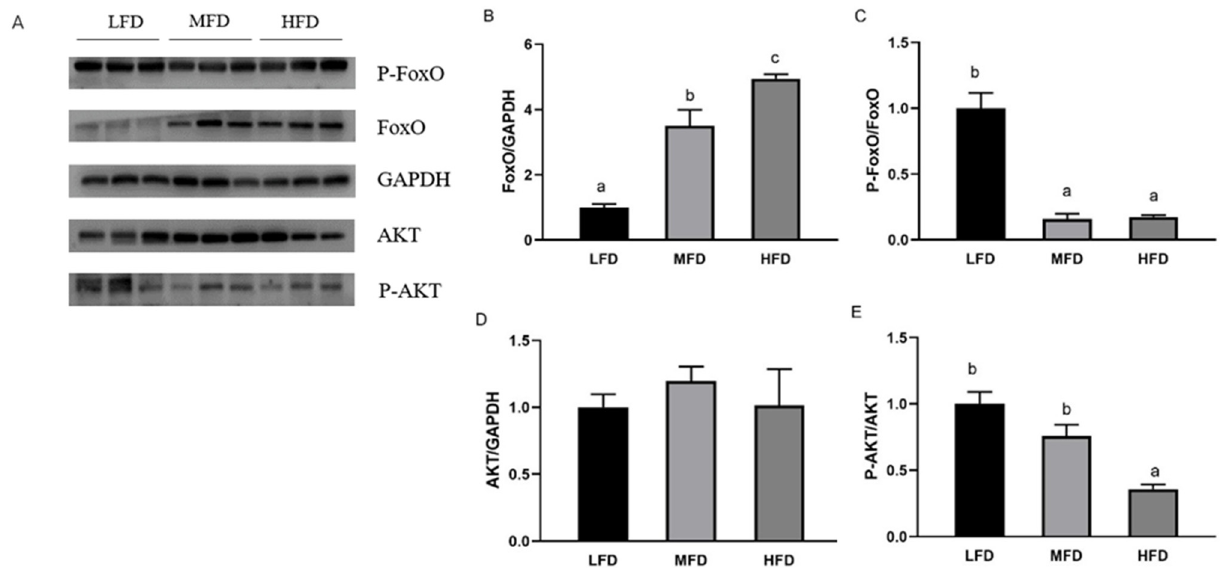
Figure 8. Protein levels in the hepatopancreas of abalone after feeding trial ( A ). The relative protein abundances of FoxO ( B ), P-FoxO ( C ), AKT ( D ), and P-AKT ( E ) in hepatopancreas were measured by Western blot and expressed as relative expression values to those in the LFD group. Values are represented as mean ± S.E., n = 3. Values with different letters are significantly different ( p < 0.05).